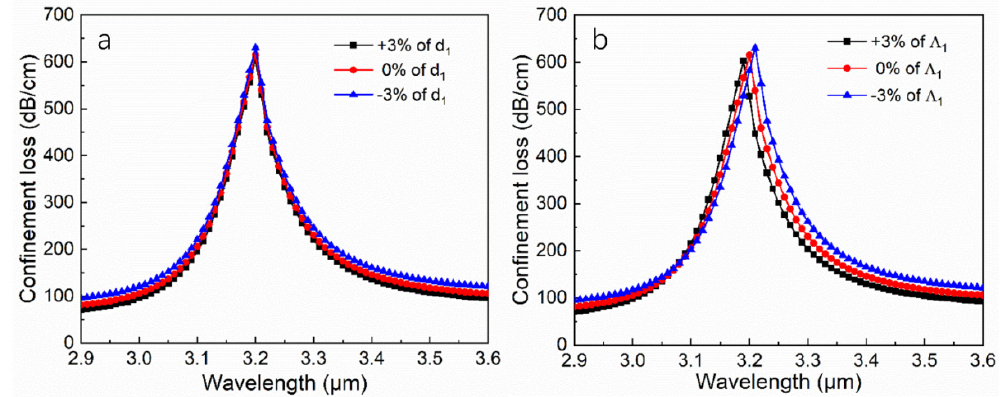
Figure 6. Loss spectra on variation of ( a ) cladding-hole diameter d 1 of ±3% and ( b ) pitch Λ 1 of ±3%.